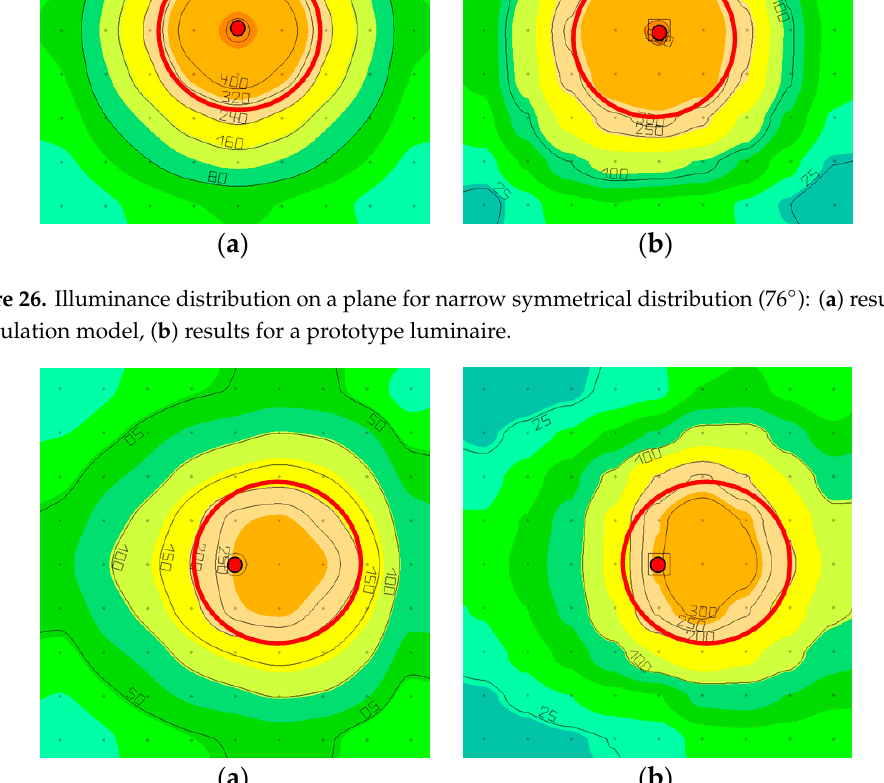
Figure 27. Option 1, illuminance distribution on a plane for asymmetrical distribution ( a ) results for a simulation model, ( b ) results for a prototype luminaire.